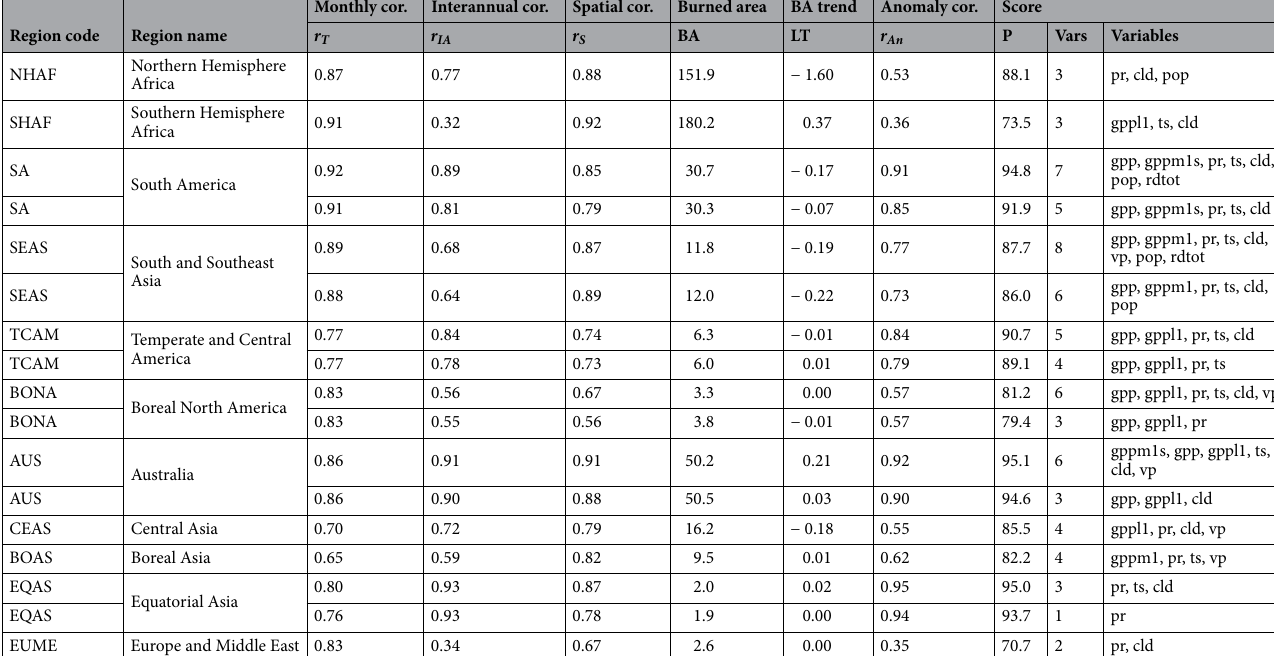
Table 2. Regional predictors of fire. Performance of the best and minimal models for each region with respect to each of the five performance measures described in Methods, along with the aggregate performance score. In some regions, the best model is the same as the minimal model. Also mentioned are the variables that form the inputs of the models. BA is Burned Area, and LT is long-term trend in spatially aggregated yearly timeseries. Variables are as follows: gppl1—cumulative GPP, gppm1—growing season GPP (northern hemisphere), gppm1s—growing season GPP (southern hemisphere), pr—precipitation, ts—temperature,